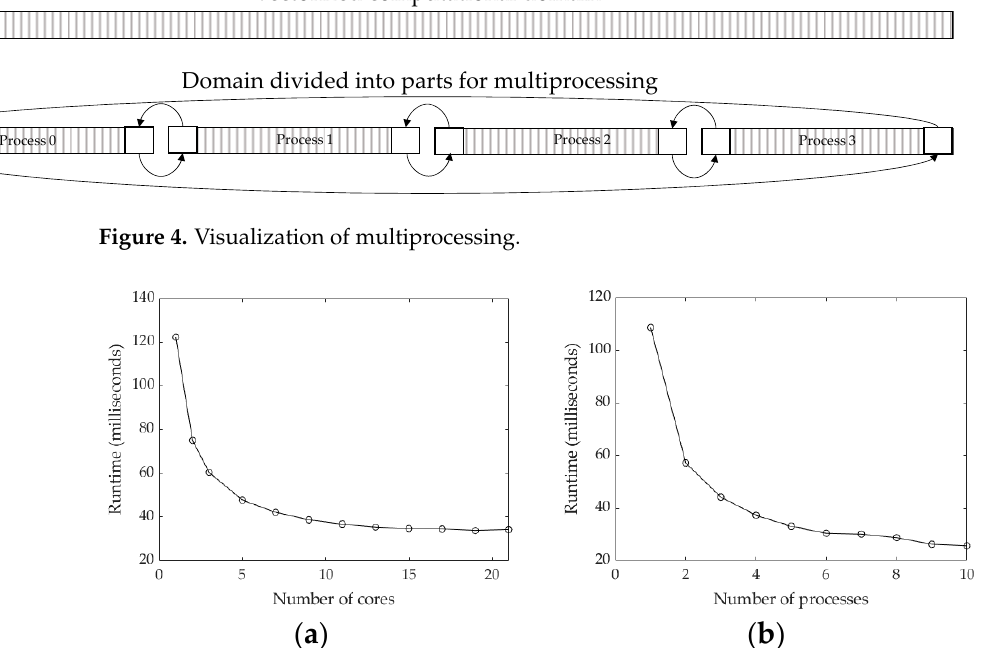
Figure 5. Single iteration of LB runtime: ( a ) multithreaded and ( b ) multiprocessor.